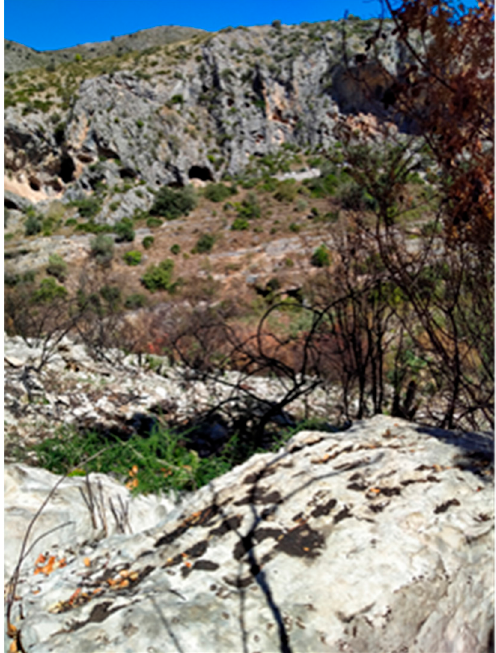
Figure 13. Beneath the slope in front of the praying area, there is a stone probably for ritual. The photo is taken by the author.